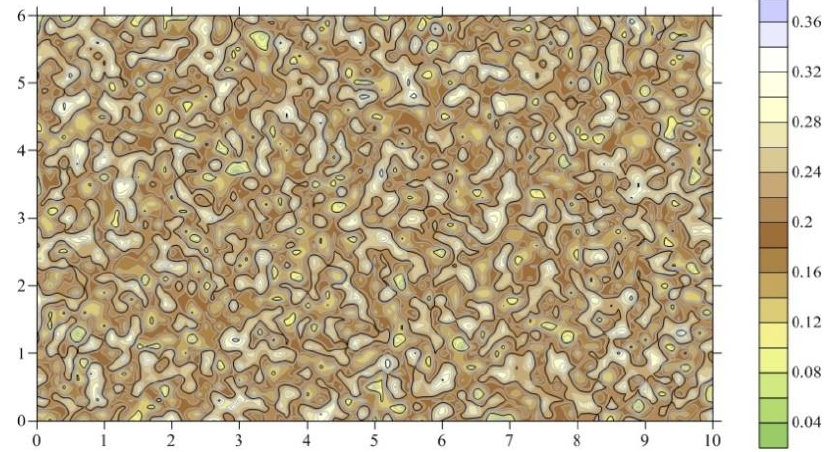
Figure A1. Spitial distribution of porosity heterogeneity.